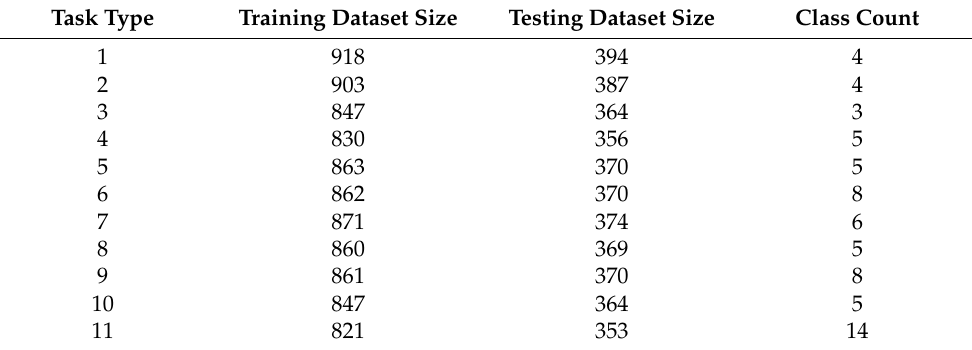
Table 3. Brief information about datasets of programs solving tasks of different